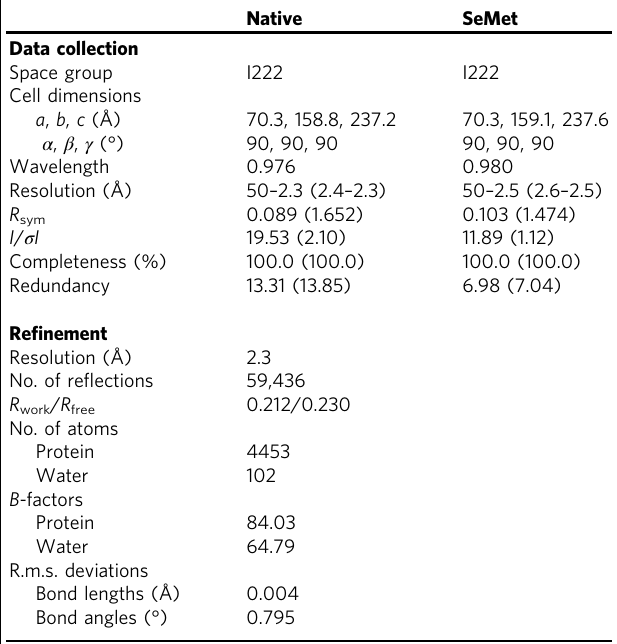
Table 1 Data collection, phasing and re fi nement